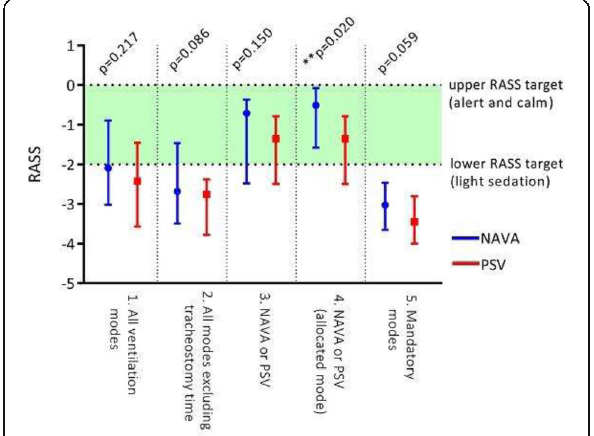
Fig. 1 (abstract 0052). Median (IQR) of hourly RASS score in different phases of ventilatory